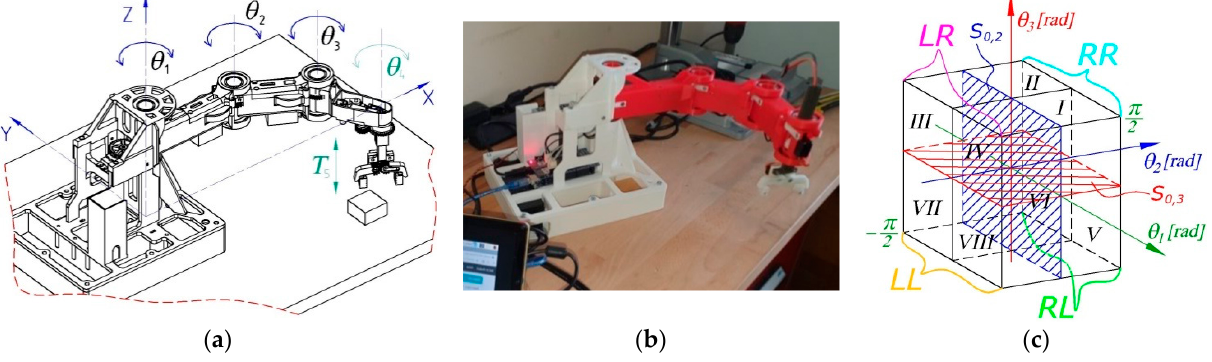
Figure 14. ( a ) Model and ( b ) prototype of a 3D printed educational robot. ( c ) Three-dimensional configuration space divided by types.